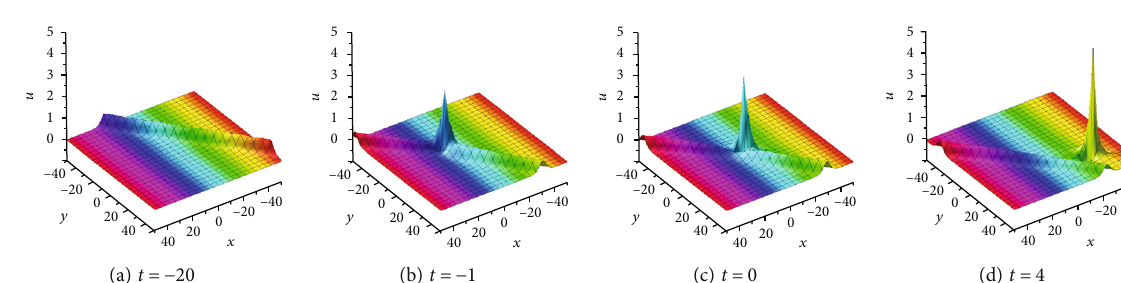
Figure 14: Single soliton spit forward lump-type soliton.